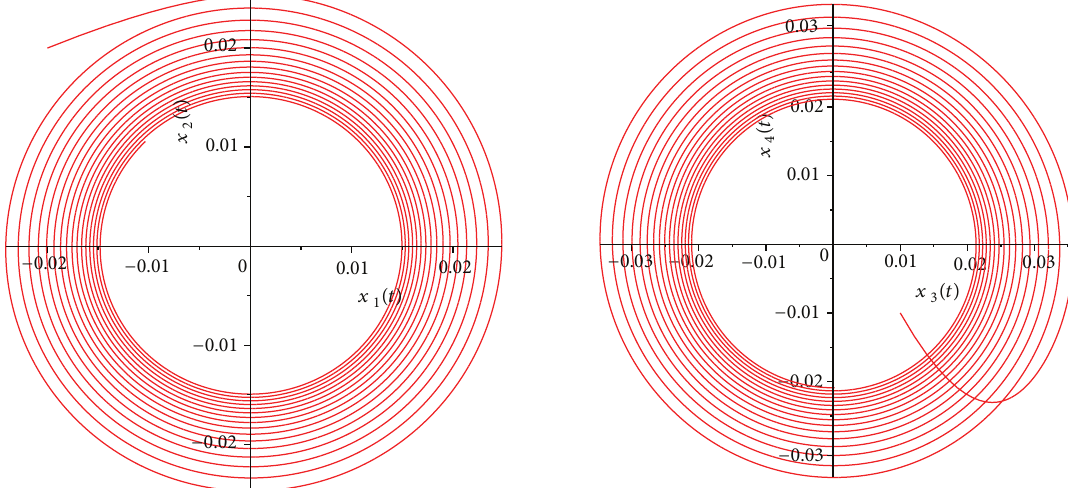
Figure 9: Trajectory projection starting from (𝑥 1 ,𝑥 2 ,𝑥 3 , 𝑥 4 ) = (−0.02, 0.02, 0.01, −0.01) converges to the E.S. when (𝜉 1 ,𝜉 2 ) = (0.2, −0.2) .